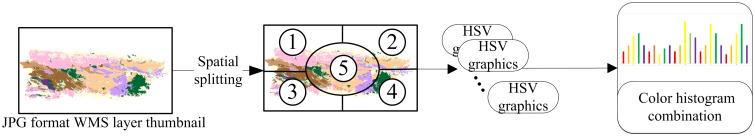
Image feature construction of a WMS layer based on spatial splitting.